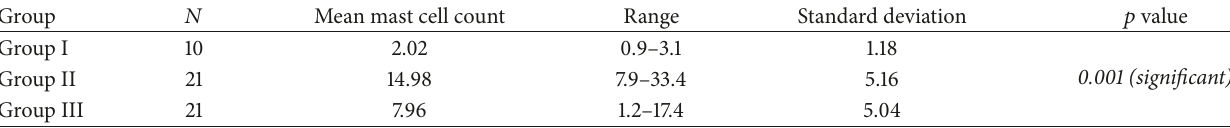
Table 2: Comparison of mast cell distribution among study groups using Kruskal–Wallis test.